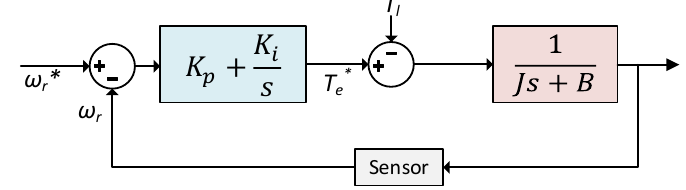
Figure 6. Feedback speed control loop.